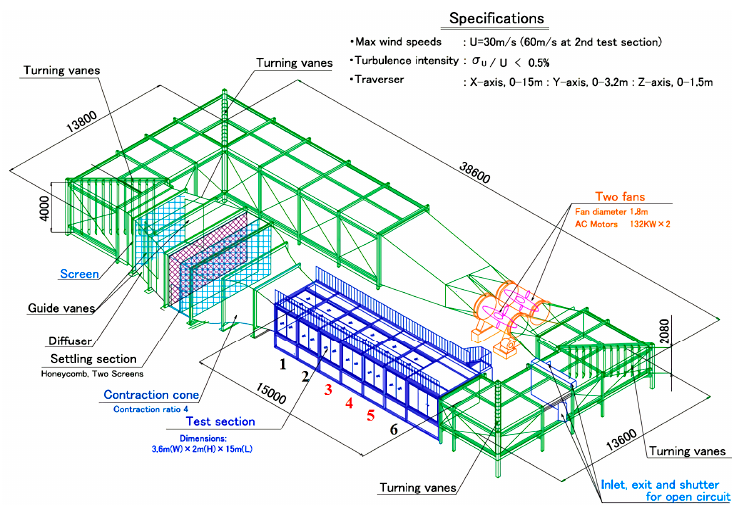
Figure 3. Wind tunnel facility used in the present study.